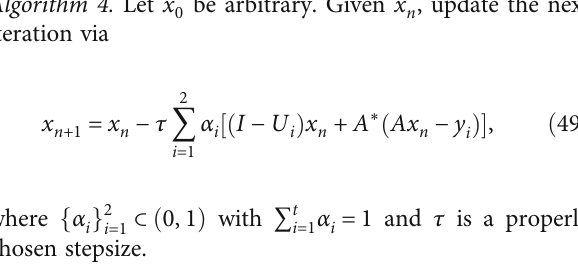
Algorithm 4. Let x 0 be arbitrary. Given x n , update the next iteration